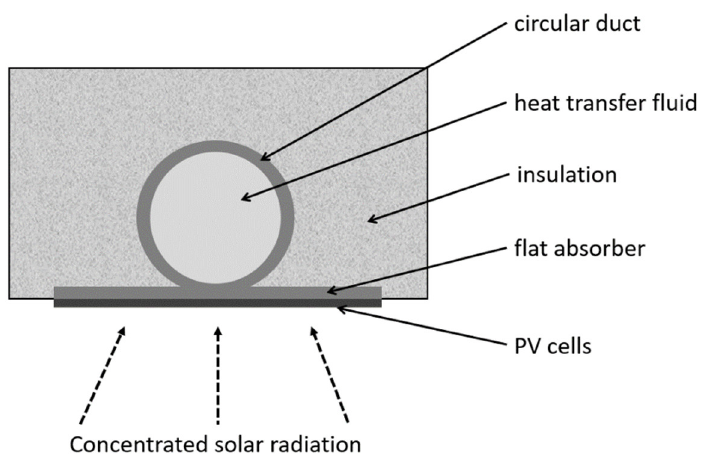
Figure 6. The cross-sectional view of typical circular-duct heat receiver.